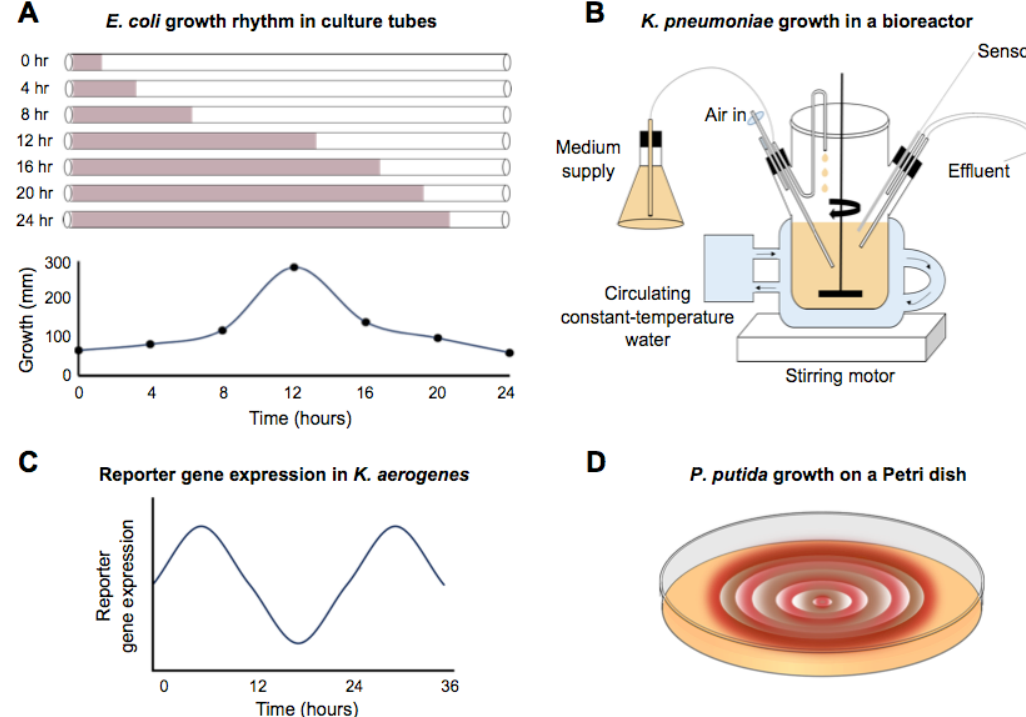
Figure 2. Schematic representations of the various rhythms observed for non-photosynthetic Eubacteria. ( A ) Growth rhythms observed in E. coli by growth in a long culture tube filled with liquid media and inoculated at one end. A dye was included to measure the growth front as the culture moves down the tube free-running rhythm. The graph summarizes the growth with 4 h intervals over 24 h, corresponding to hours 40 to 64 of the original experiment by Rogers and Greenbank [26]. Subsequent analysis of the data of the E. coli growth rhythm by Halberg and Conner suggests a 20.6 h period rather than 24 h [27]. ( B ) Sturtevant [30] measured the growth rhythm in Klebsiella pneuomoniae in a bioreactor. Samples were taken out every 15 or 30 min, and the optical density was measured. ( C ) Reporter gene rhythms detected in Klebsiella aerogenes [31]. A gene fusion between a motility gene ( motA ) and the reporter GFP allowed detection of circa 24 h rhythms. Similar types of long rhythms of reporter genes have been observed in B. subtilis [32–35]. ( D ) Morphological rhythms were observed by Soriano et al. [36] when studying Pseudomonas putida by incorporating dyes (Congo Red or Coomassie Brilliant Blue) that detect changes in the redox state or cell surface of P. putida . Growth “rings” were then observed that had circa 24 h rhythms.